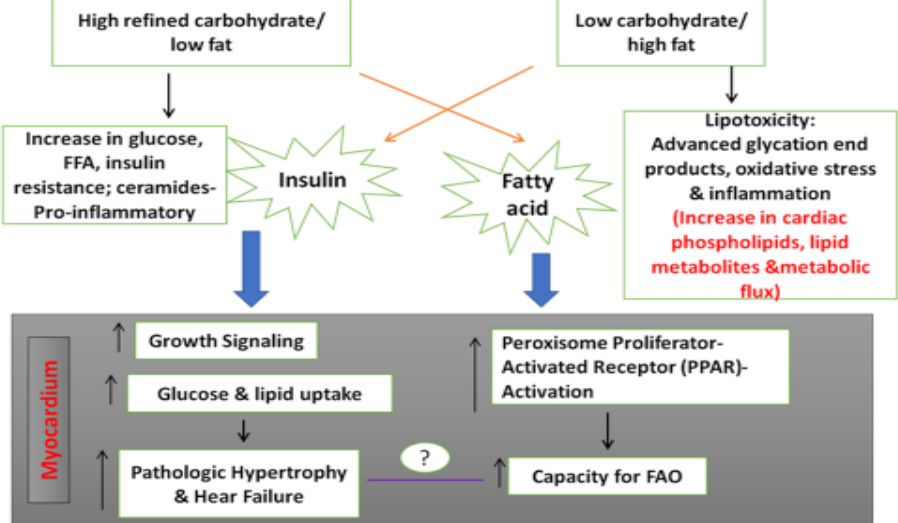
Figure 3. Effects of high-glucose or high-saturated-fat diets on development of cardiomyocyte and cardiac hypertrophy. (Modified from Reference [48], Stanley et al., Circ Res 2012, American Heart Association , Journal).